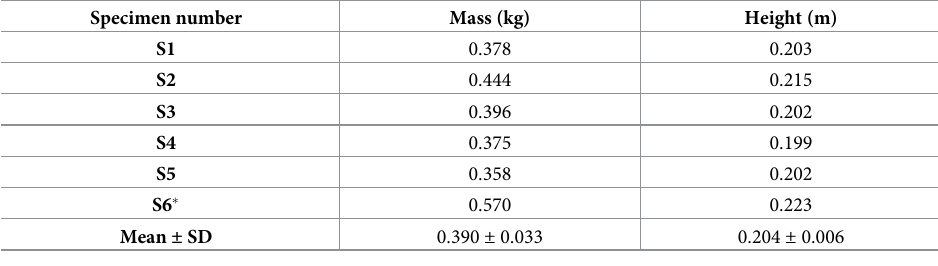
Table 1. Descriptive data of porcine cervical spine segments